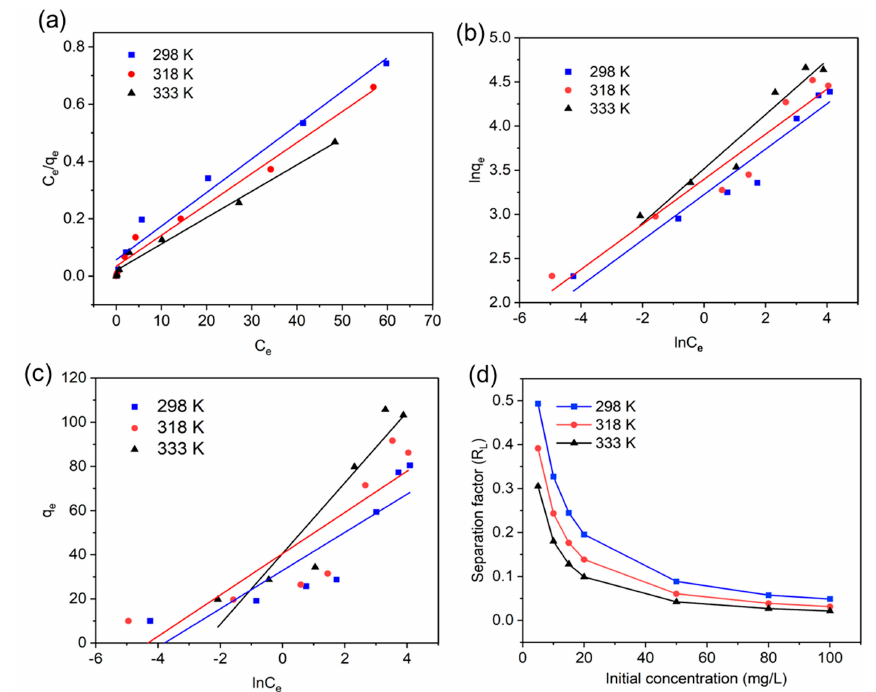
Figure 5. Linearized form of ( a ) a Langmuir isotherm model; ( b ) a Freundlich isotherm model; ( c ) a Temkin isotherm model; ( d ) the separation factor obtained in the adsorption experiment running at different initial concentrations of MO and